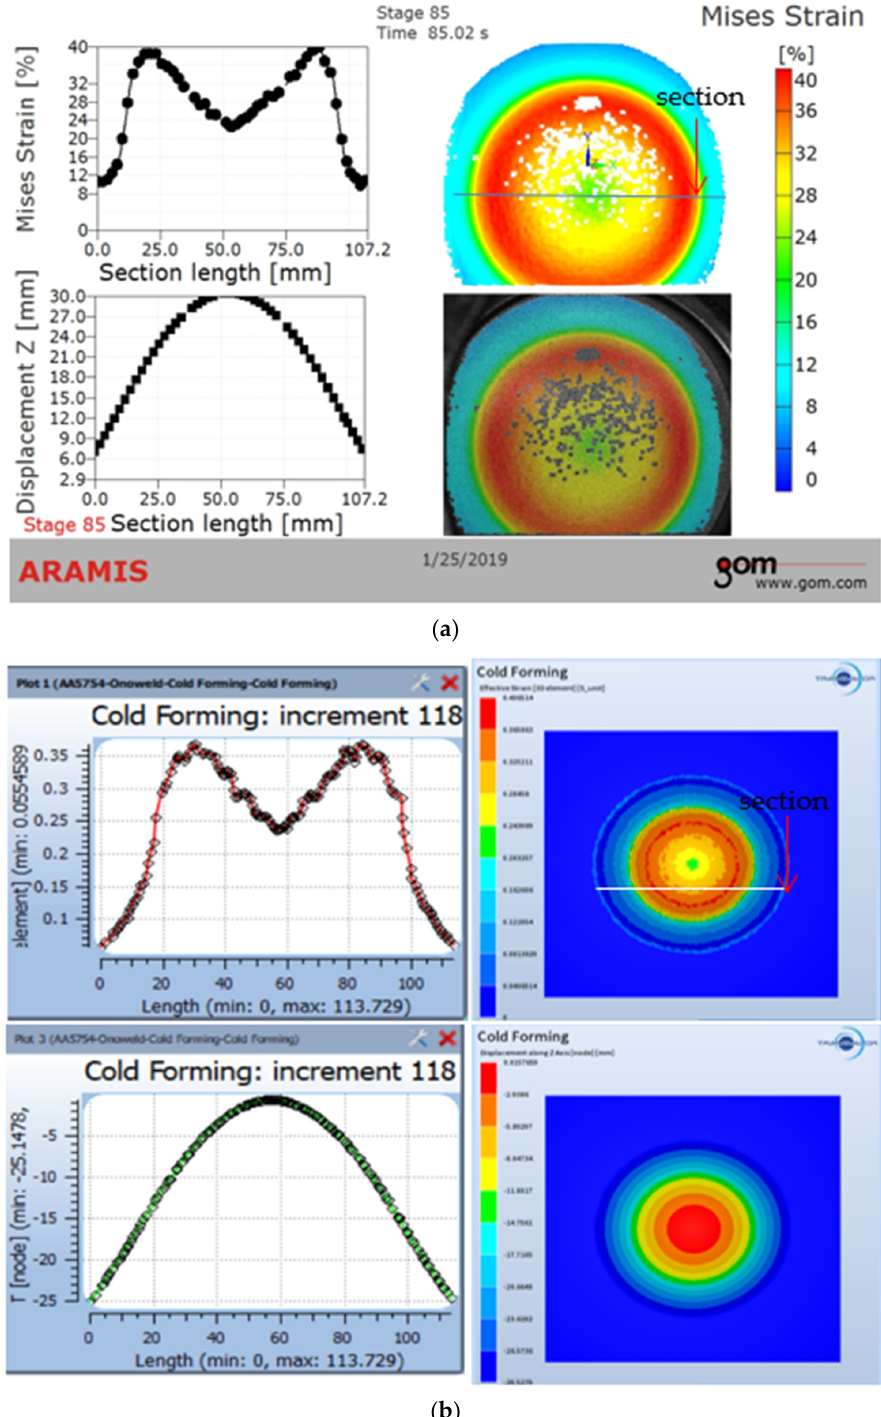
Figure 4. Comparison of Mises strain and displacement across the blank when punch displacement is 30 mm between ( a ) experimental; ( b ) simulation by Forge NxT.